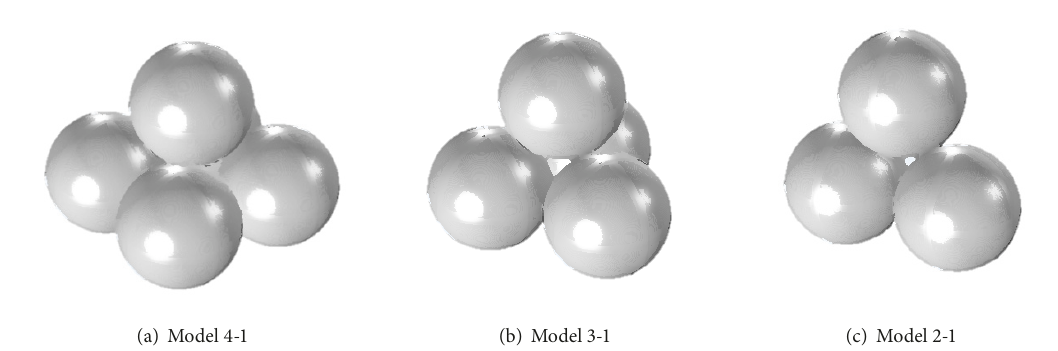
Figure 3: Schematic diagram of 3 kinds of proppant